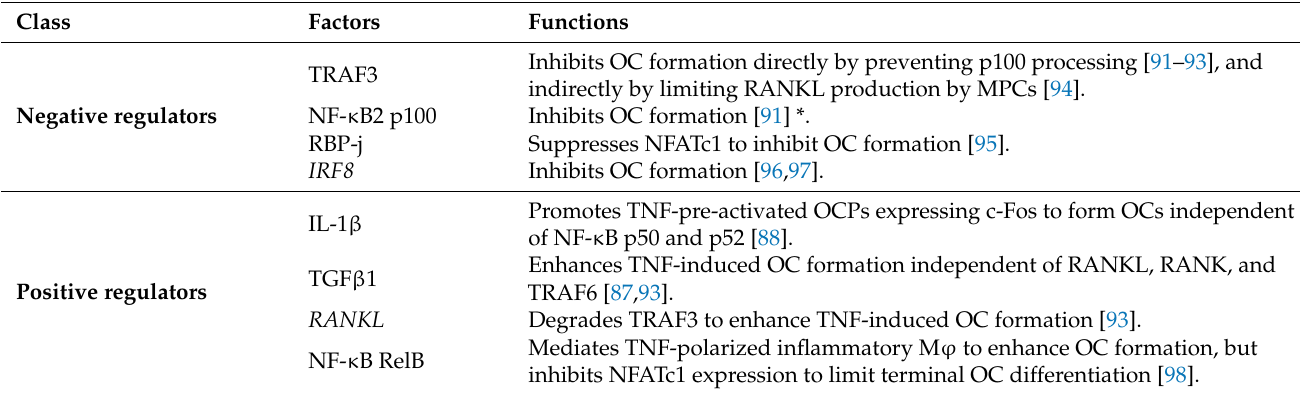
Table 1. Factors that regulate TNF-induced OC differentiation.